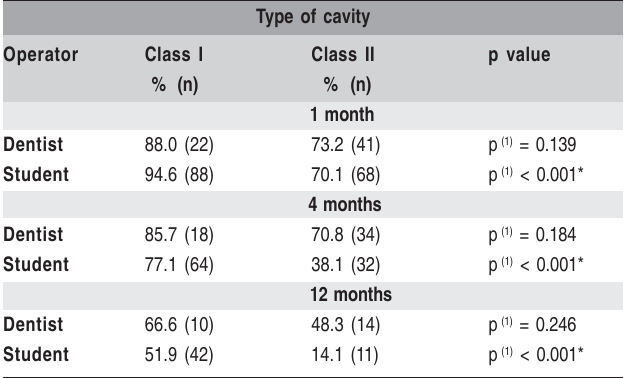
Table 3: Distribution of success rate according to the type of cavity at 1, 4 and 12 months